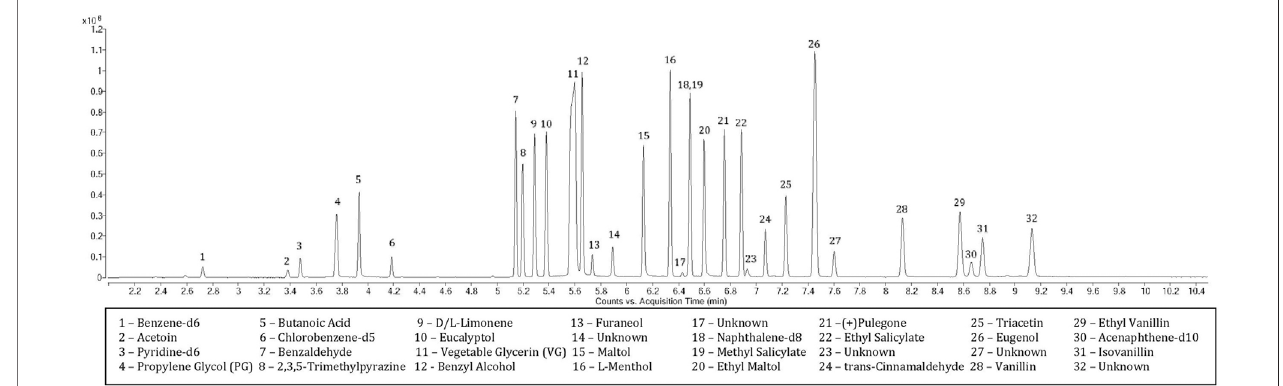
FIGURE 1 | Total Ion Chromatogram of Targeted Flavoring Chemicals and Internal